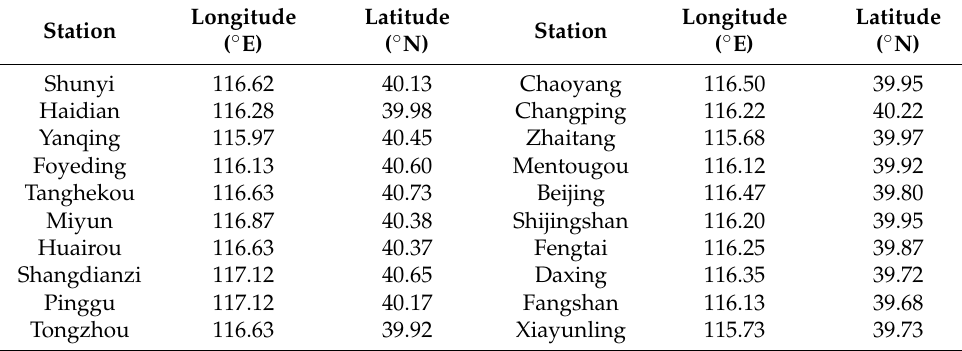
Table 1. The location information of 20 rain-gauged stations.